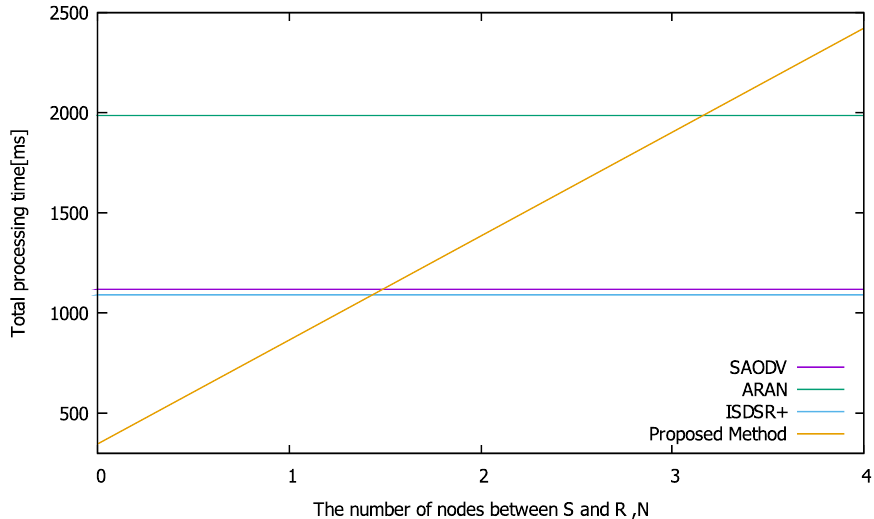
Figure 7. Routing overhead performance where n =